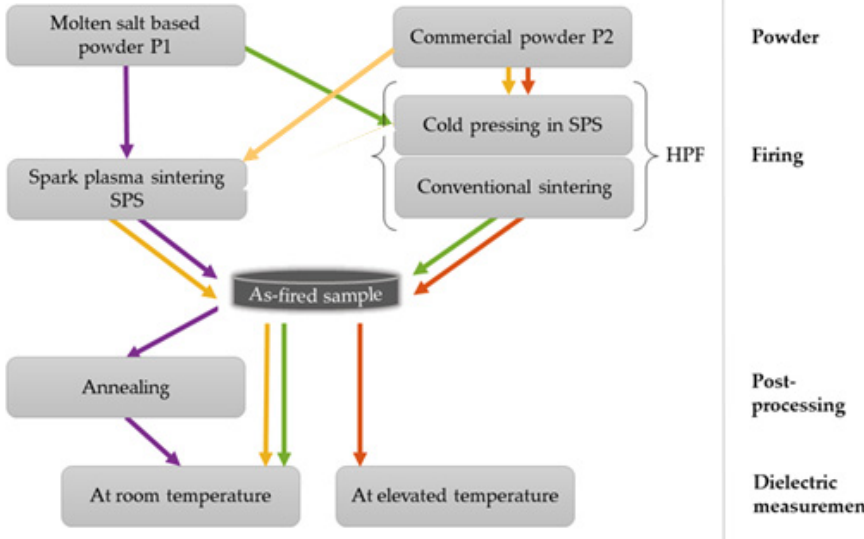
Figure 3. Scheme of the experiments. Steps applicable at the same time are in the same horizontal level.